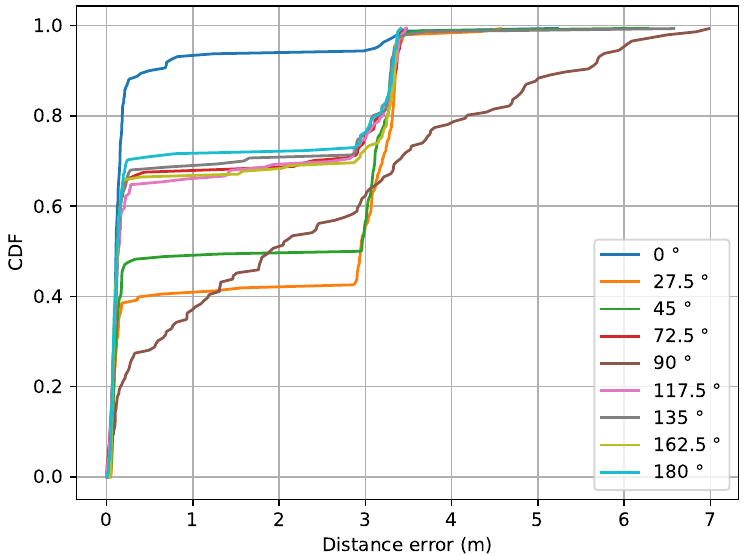
Figure 13. CDF plot of the influence of the angle between the RF source and backscatter with ∆ x ∆ x a = 250cm and rf = 190